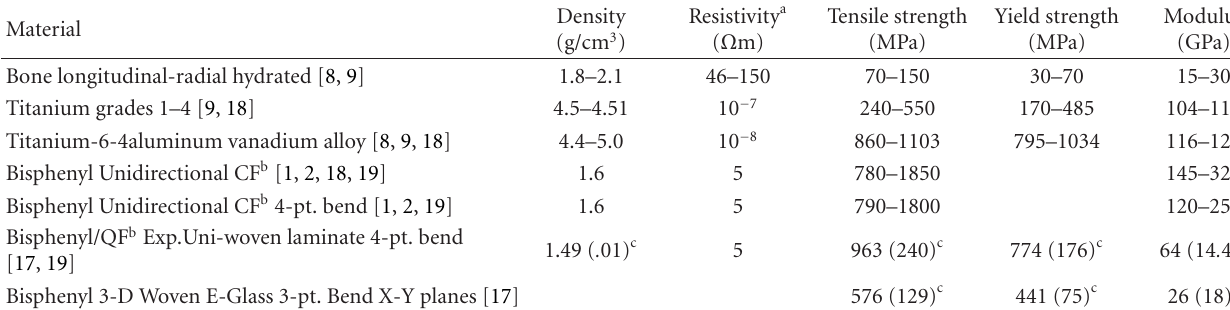
Table 1: Biomaterial